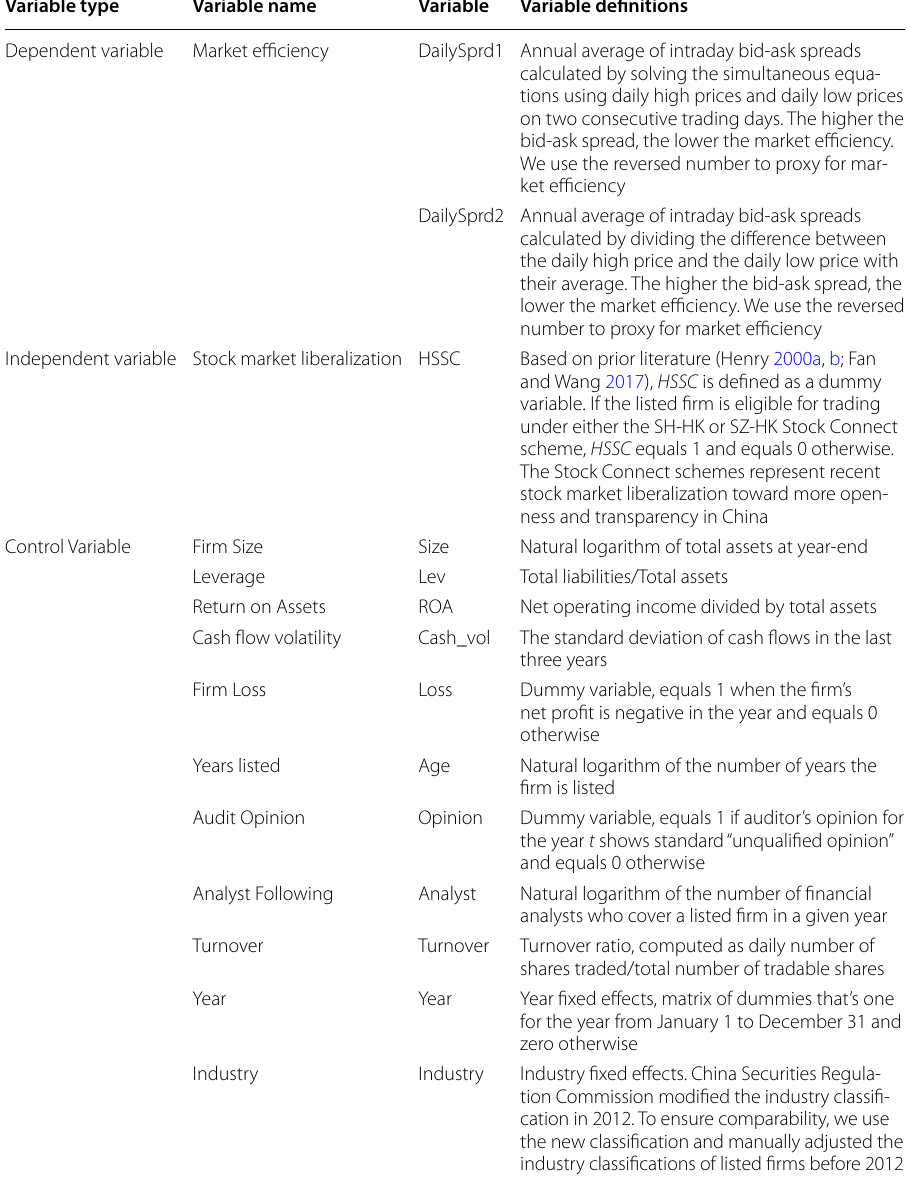
Table 12 Variable